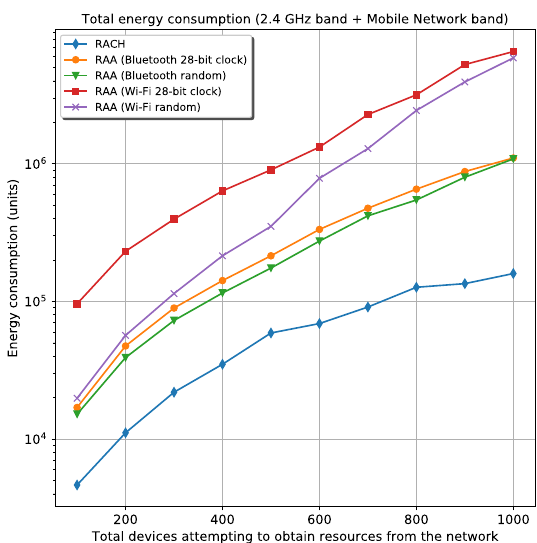
Figure 6. Total energy spent in all bands for the classic RACH and four different RAA procedures.